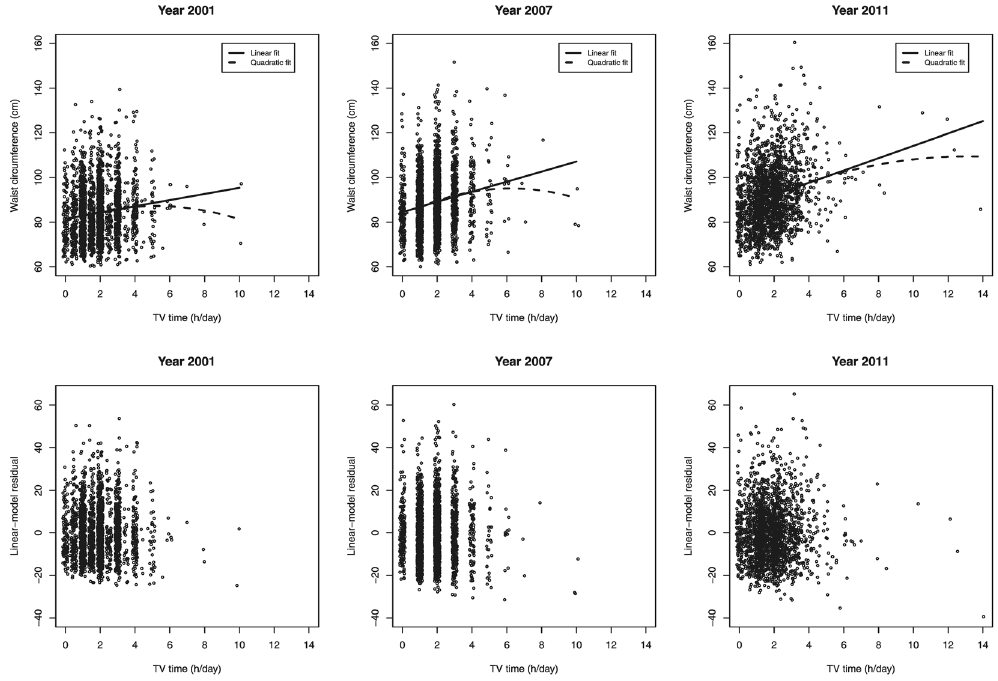
Figure 1. Linear Regression Models with a quadratic term (dashed line) and without it (solid line). Residual plots are for the model with only the linear term included. Jitter, that is a uniform random variable on the interval [ 2 0.3, 0.3], was added to x-axis for enhanced discernibility, but